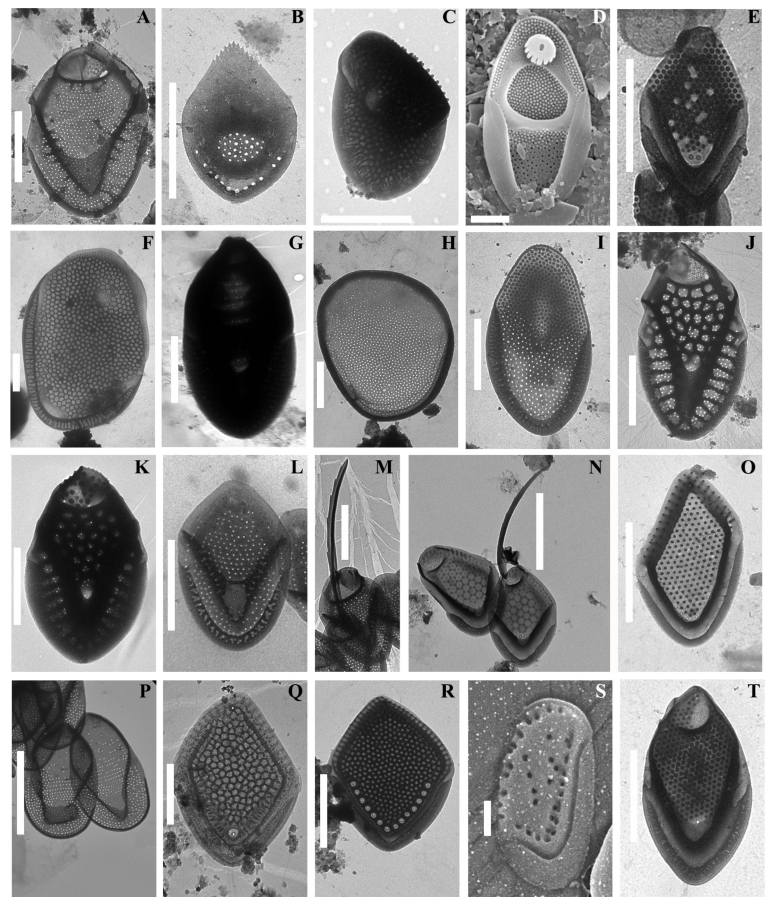
Figure 2. Scales and bristles of Mallomonas . ( A ) M. acaroides . ( B ) M. akrokomos . ( C ) M. adamas . ( D ) M. bangladeshica . ( E ) M. binocularis . ( F ) M. bronchartiana . ( G ) M. cattiensis . ( H ) M. caudata . ( I ) M. ceylanica . ( J ) M. crassisquama . ( K ) M. crassisquama var. papillosa . ( L , M ) M. cf. cristata . ( N ) M. distinguenda . ( O ) M. elevata . ( P ) M. elongata . ( Q ) M. favosa f. favosa . ( R ) M. favosa f.